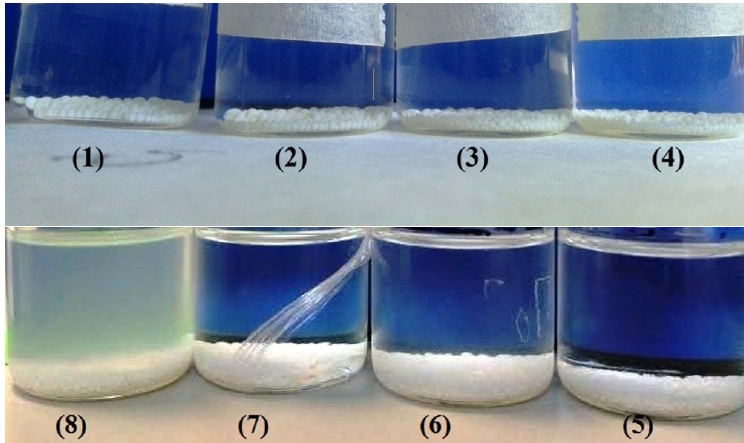
Figure 7. Physical aspect of the reaction mixture (photos were taken after 72 hours). ( 1 ): TMOF in 100% isooctane, ( 2 ): TMOF in the presence of 20% DCM, ( 3 ): TEOF in 100% isooctane, ( 4 ): TEOF in the presence of 20% DCM, ( 5 ): TPOF in 100% isooctane, ( 6 ): TPOF in the presence of 20% DCM, ( 7 ): TBOF in 100% isooctane, ( 8 ): TBOF in the presence of 20% DCM, showing a turbidity.